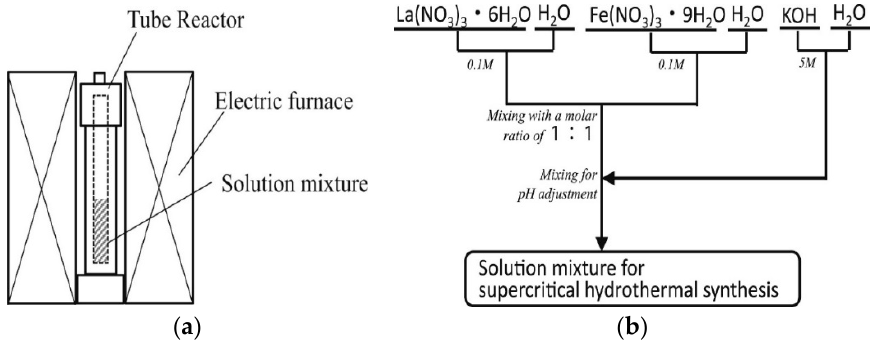
Figure 24. ( a ) Schematic diagram of a batch-type reactor vessel and ( b ) preparation of the solution mixture for supercritical hydrothermal synthesis (Reprinted with permission from